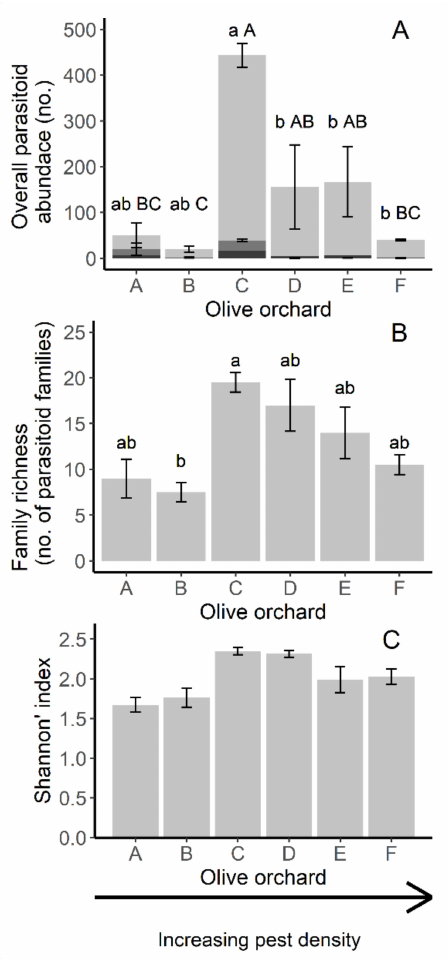
Figure 3. ( A ) Overall abundance (no.) of hymenopteran parasitoids (light gray), P. demades (gray), and Pteromalidae (dark gray) trapped in malaise traps in each olive orchard (i.e., A–F, with increasing pest density from A to F) during the entire sampling period. Different capital letters indicate a significant difference among the number of trapped parasitoids, while different lower-case letters indicate a significant difference between the number of P. demades ( p < 0.05), ( B ) family richness, and ( C ) Shannon index. All values are means ±